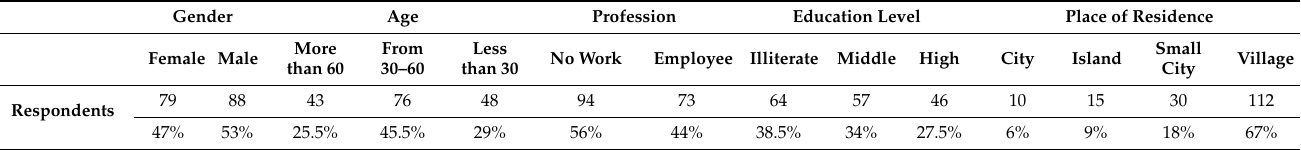
Table 8. Demographic characteristics of informants according to the ethnobotanical